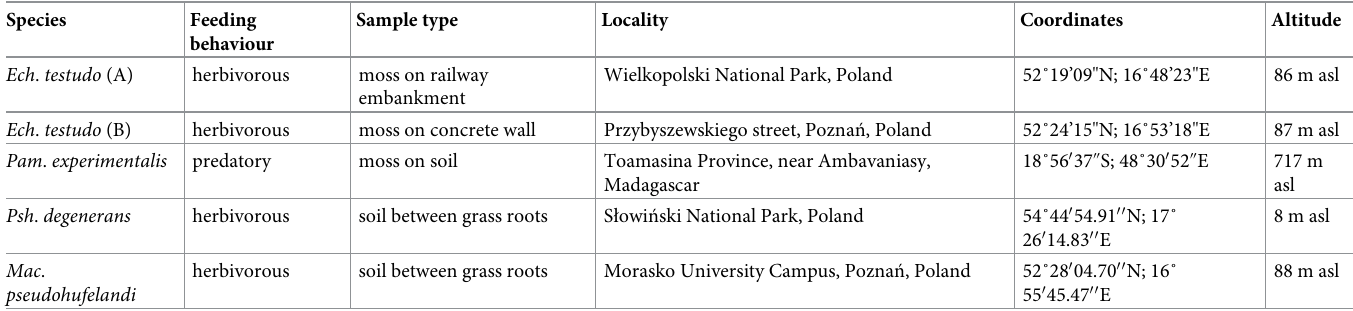
Table 1. Species used in experiments and their feeding behaviour and